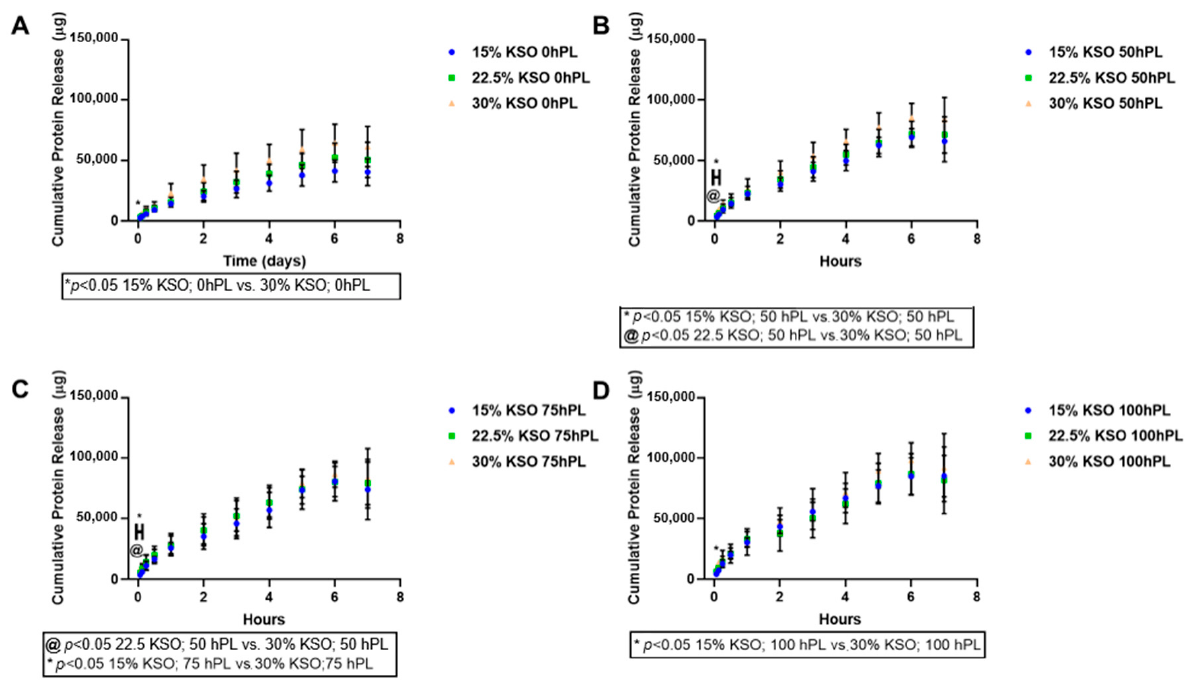
Figure 3. Total protein release against varying KSO hydrogel weight percent. Total protein release against varying KSO hydrogel weigh percent was quantified by BCA assay and plotted for 0% ( A ), 50% ( B ), 75% ( C ), and 100% ( D ) hPL-loading concentration. Increase in KSO hydrogel weight percent decreased total protein release.